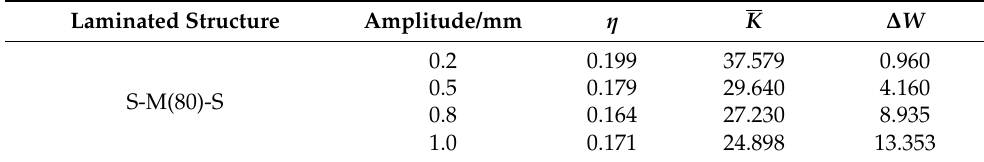
Table 8. Dynamic parameter variation with amplitude.